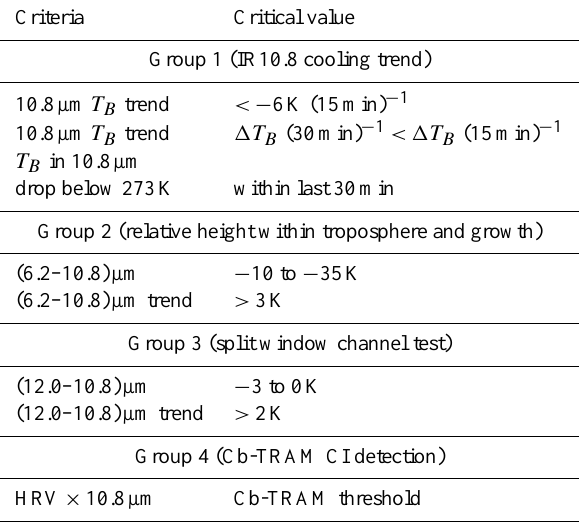
Table 2. Grouped set of criteria for CI